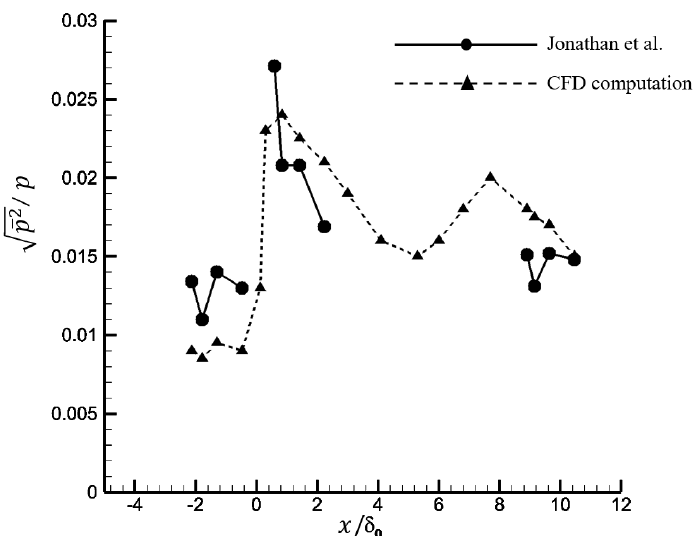
Figure 4. The distribution of normalized fluctuating pressure along the flow